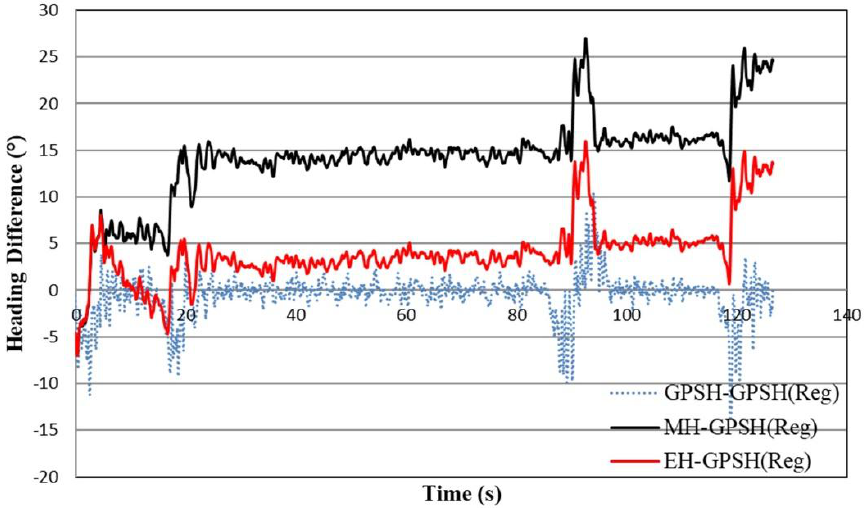
Figure 9. Heading difference based on the reference heading for a concave polygon field.